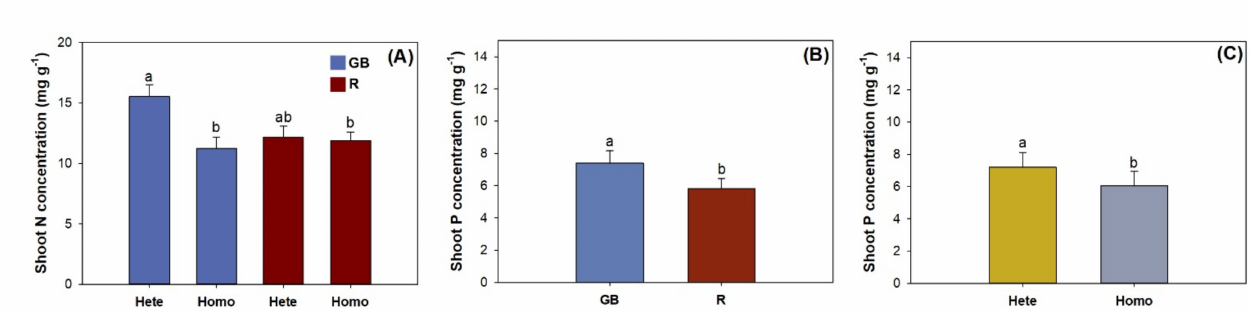
Figure 3. Nitrogen (N) and phosphorus (P) concentrations in Pinus pumila seedlings subjected to green-and-blue light (GB) and red-light enriched spectra (R) in heterogeneous (Hete) and homogeneous (Homo) nutrient patterns. Error bars indicate standard deviations. Different letters above bars indicate significant differences according to Duncan test at the 0.05 level. ( A ) shoot N concentration of seedlings subjected to combined light spectra and nutrient pattern; ( B ) shoot P concentration in response to light spectra; ( C ) shoot P concentration in response to combined nutrient